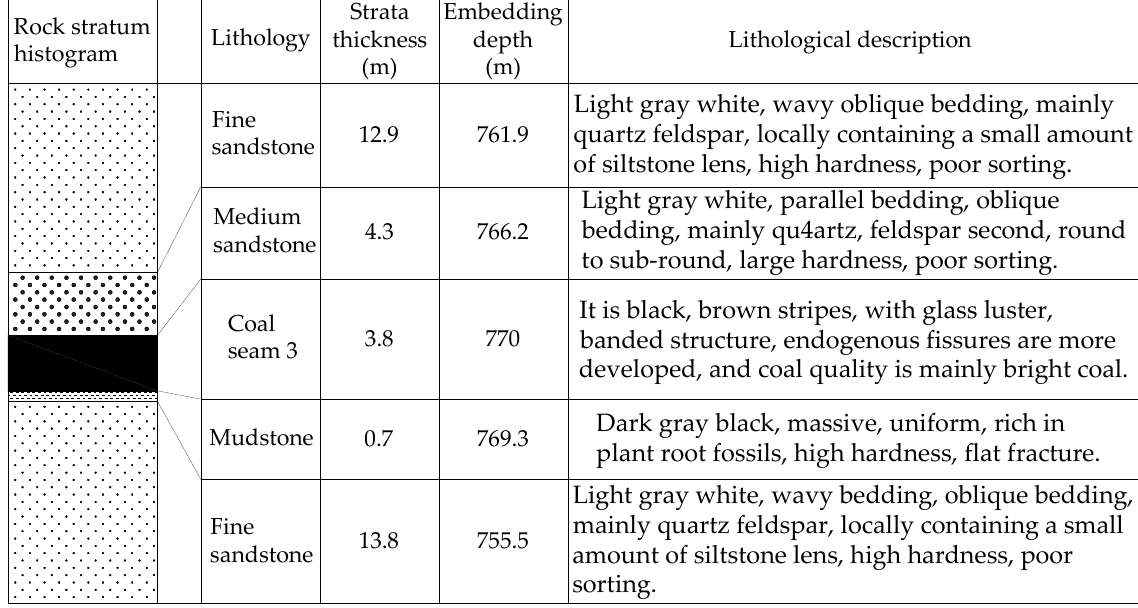
Figure 1. The 1304 working face advanced section mining roadway coal (rock) histogram.